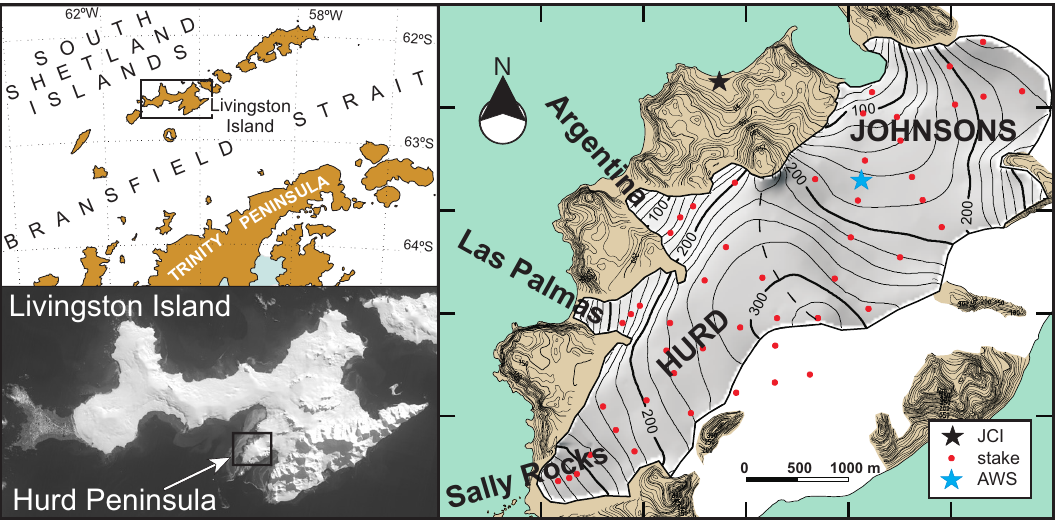
Fig. 1. Location of Hurd Peninsula, Livingston Island, with the position of Juan Carlos I Station (JCI), the AWS and the mass balance stakes in